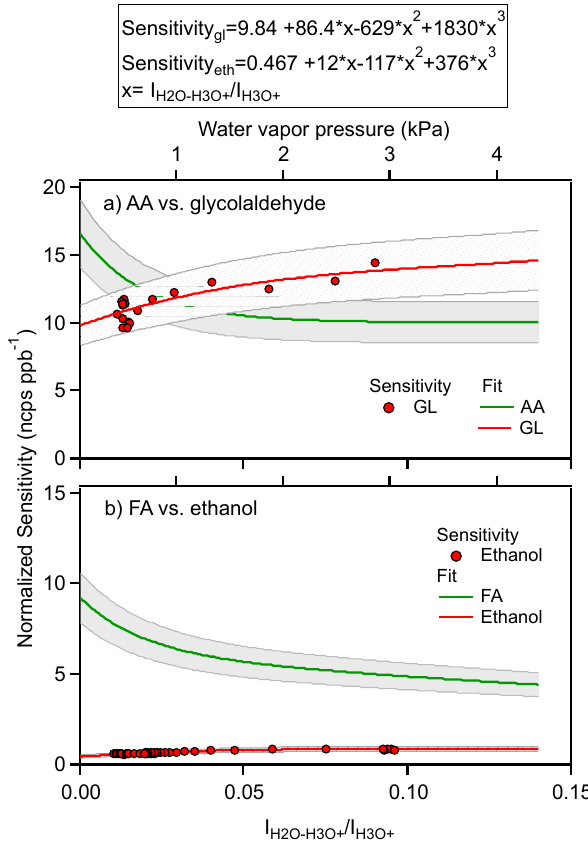
Figure 7. Humidity dependence of the PTR-MS response to (a) gly- colaldehyde and AA and (b) ethanol and FA at E/N = 125Td. The polynomial fits shown in the figure were used to quantify and cor- rect for the humidity dependence of the glycolaldehyde and ethanol sensitivities. The shaded areas represent ± 15% of the fitted